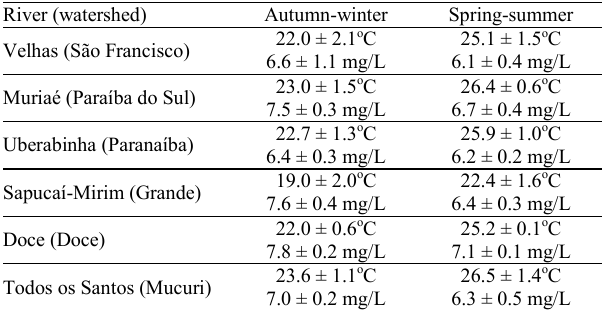
Table 1. Water temperature and dissolved oxygen (mean ± SD) of the six target rivers in Minas Gerais State, from 1997 to 2007. Source: IGAM (2009).